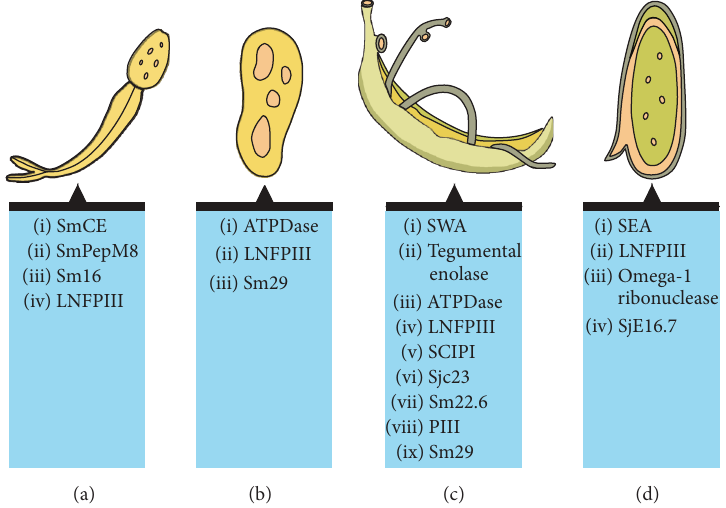
Figure 1: Schistosome-derived molecules from different life stages. Four life stages of S. mansoni are represented from (a) to (d): cercariae, schistosomulum, adult male and female pair, and egg. Despite the fact that the egg morphology has been similar to S. mansoni egg, the image represents molecules from different schistosome species. Figure created in the free version of “mind the graph” platform: https://mindthegraph.com/, followed by edition using Adobe Photoshop